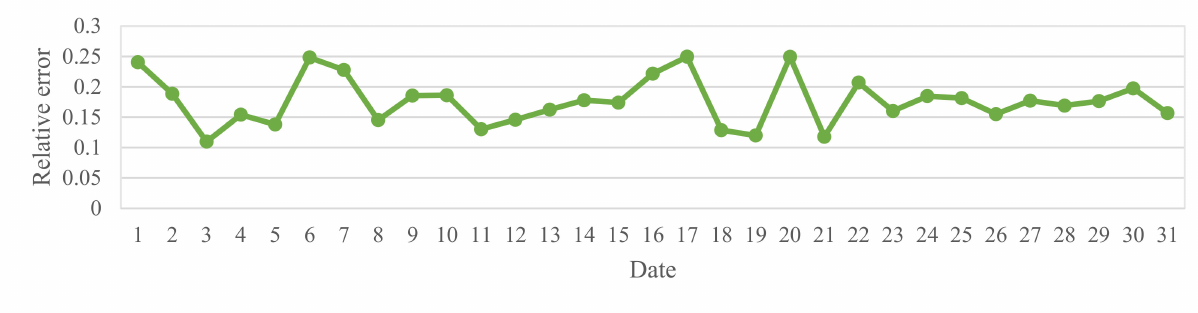
Figure 4. Relative error of cash flow forecast of G company in February 2019.